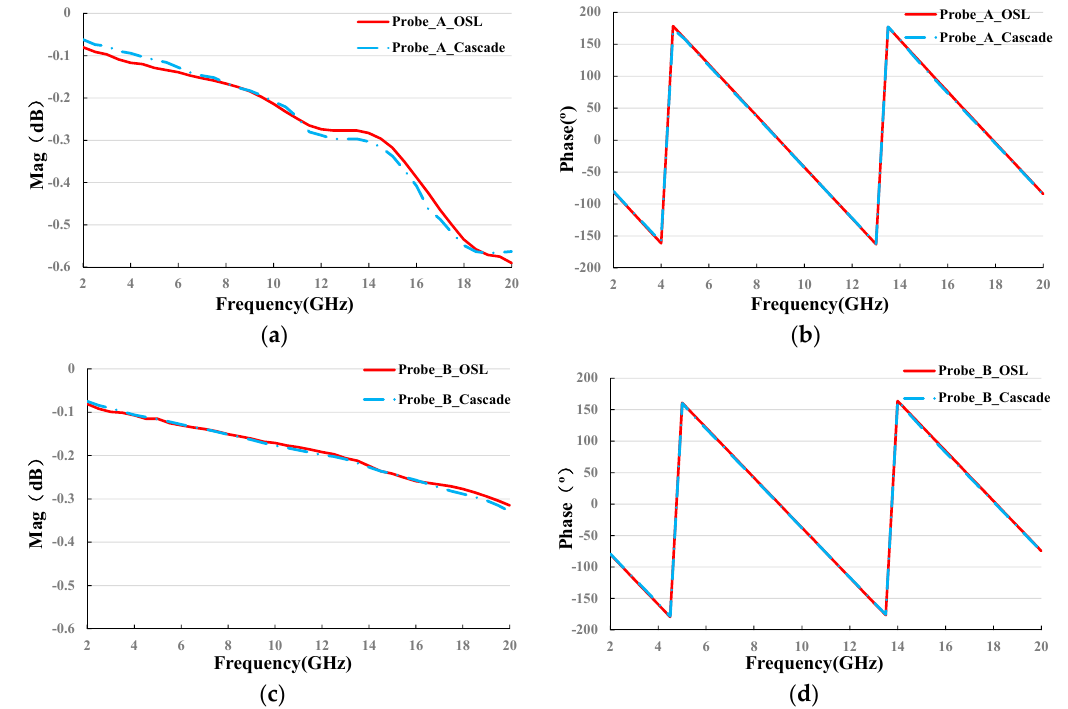
Figure 12. Extracted S ‐ parameter results of the probes, with ( a , b ) corresponding to amplitude and phase of S 21 of the SG probe (probe A), respectively; ( c , d ) corresponding to amplitude and phase of S 21 of the GSG probe (probe B), respectively.